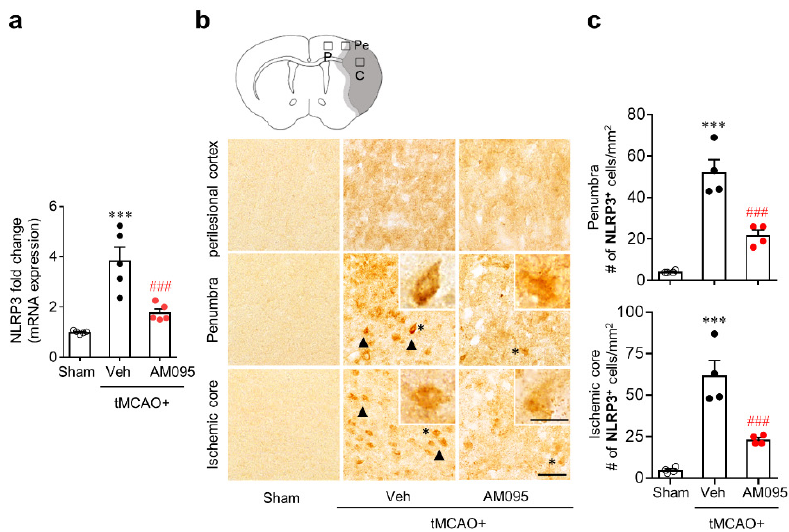
Figure 1. Lysophosphatidic acid receptor 1 (LPA 1 ) antagonist attenuates nucleotide-binding oligomerization domain-like receptor family pyrin domain containing 3 (NLRP3) upregulation in injured brains after transient middle cerebral artery occlusion (tMCAO) challenge. Mice were induced with tMCAO. AM095 (30 mg/kg, p.o.) was administered immediately after reperfusion. ( a ) mRNA expression levels of NLRP3 at one day after ischemic challenge by qPCR analysis. ( b , c ) NLRP3 expression determined by immunohistochemistry at one day after tMCAO challenge. ( b) Representative images of NLRP3-immunopositive cells in perilesional cortex (P), penumbra (Pe), and ischemic core (C) regions. A graphical abstract image at the top shows cerebral areas where images in top, middle, and bottom planes are taken. Arrows indicate NLRP3-immunopostive cells. Cells in the insets are indicated as asterisks (*). ( c ) Quantification of NLRP3-immunopositive cells in penumbra and ischemic core regions. Scale bar, 50 µm (inset, 10 µm). n = 4 mice per group. *** p < 0.001 versus sham. ### p < 0.001 versus vehicle-administered tMCAO group. Neurological deficit scores of mice used for qPCR analysis and immunohistochemistry are presented as a supplementary figure (Figure S1a,b).